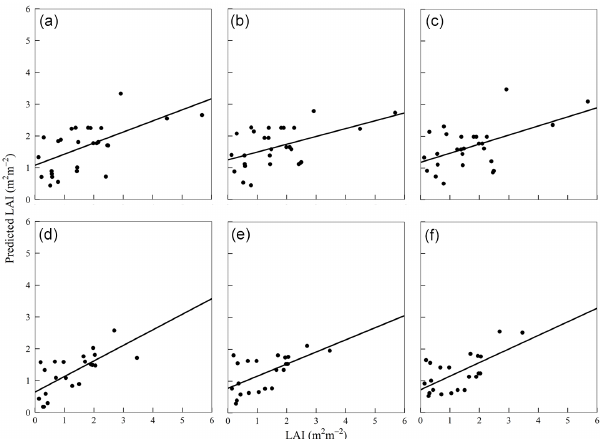
Figure 4. Scatter plots of in situ leaf area index for wheat (a–c) and pasture (d–f) vs. corresponding Landsat resolution pixels down- scaled from the Global Inventory Modeling and Mapping Studies normalized difference vegetation index version 3, Vegetation Index and Phenology Lab version 3 normalized difference vegetation in- dex, and Vegetation Index and Phenology Lab version 3 enhanced vegetation index 2 data sets. The solid lines represent the least- squares model